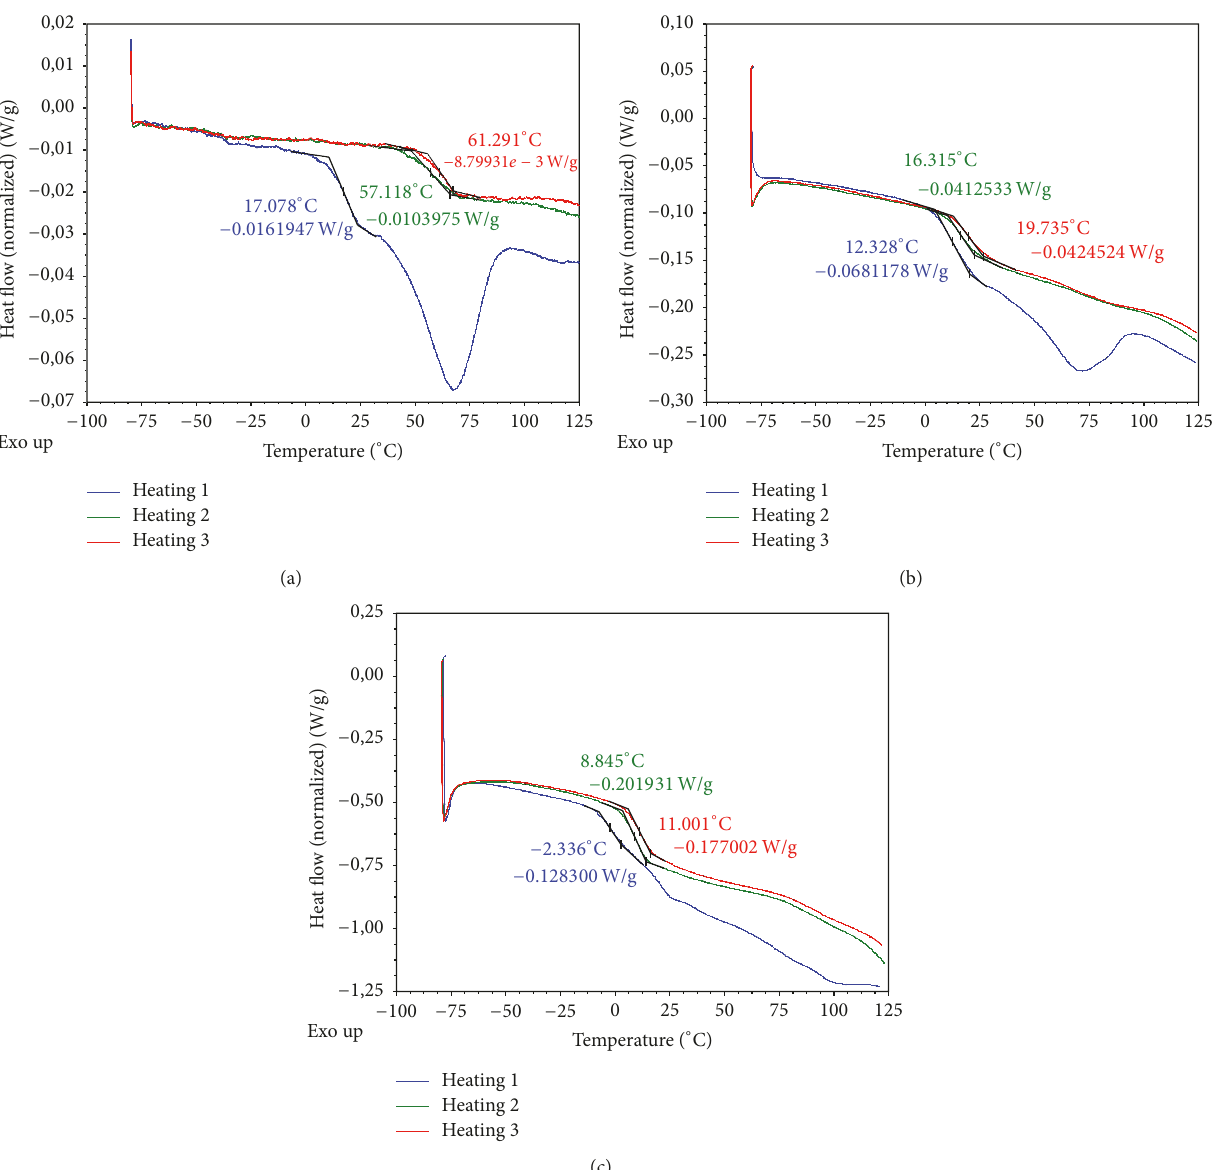
Figure 6: DSC curves of OsLu using heating rates of (a) 1, (b) 5, and (c) 20 ∘ C/min and three subsequent cycles of heating and cooling.